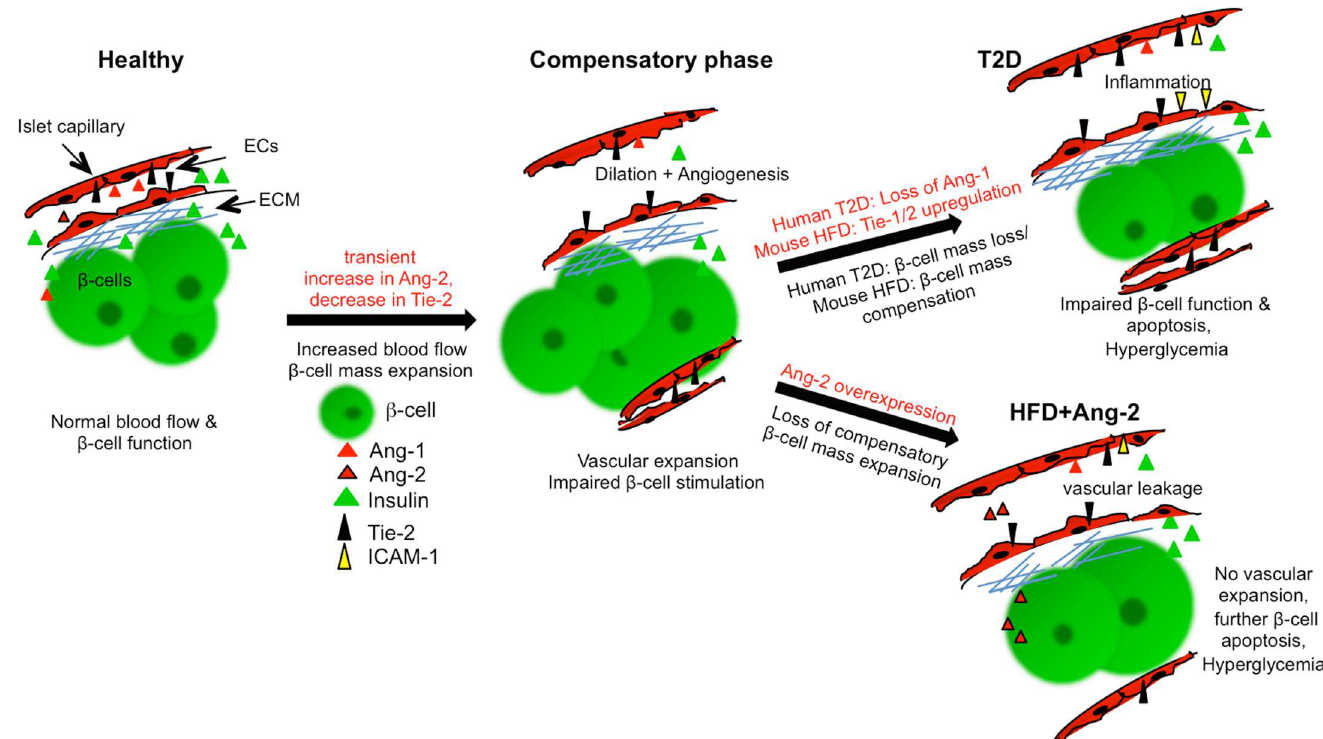
Fig 5. Islethypervascularization in T2D and effectsof Ang-2overexpression. A healthy islet is surrounded by intact capillaries, maintained by the Ang/Tiesystem and extracellular matrixsupportingthe functionand survivalof the islet. An increasedinsulin demandleads to more islet blood flow, β - cell mass and vascular expansion and consequent compensation.A transientAng-2 upregulation promotesangiogenesis, leadingislet endothelium to a non-quiescent state inhibitingTie-2 signaling.Towards humanT2D progression, β -cellfailure and apoptosisoccurs togetherwith increased islet and endothelial inflammation and islet hypervascularization.Ang-2 overexpression on the otherhand prevents β -cellmass and vascular expansion in responseto HFD with persistentislet and endothelialinflammation.